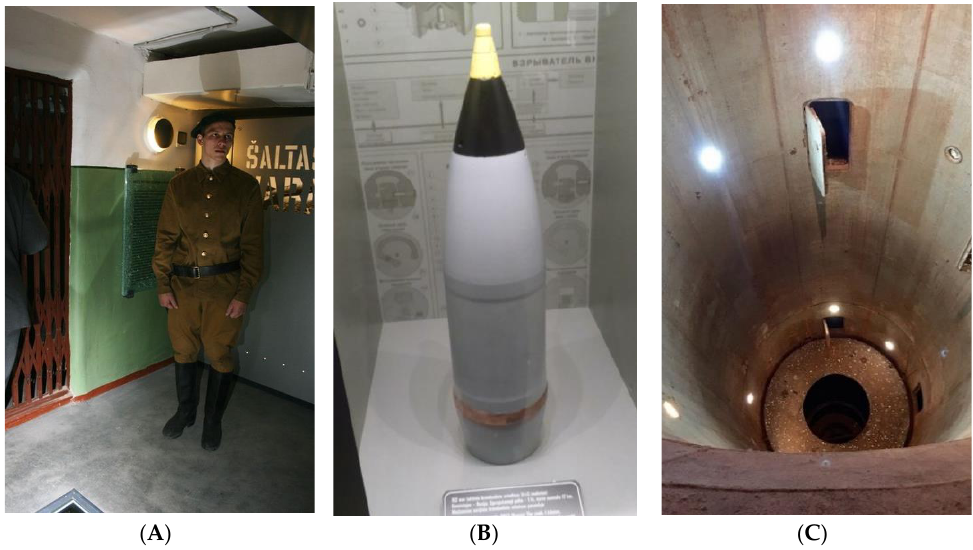
Figure 13. ( A ) Exposition in Cold War museum (former Soviet missile base; now — part of Samo-